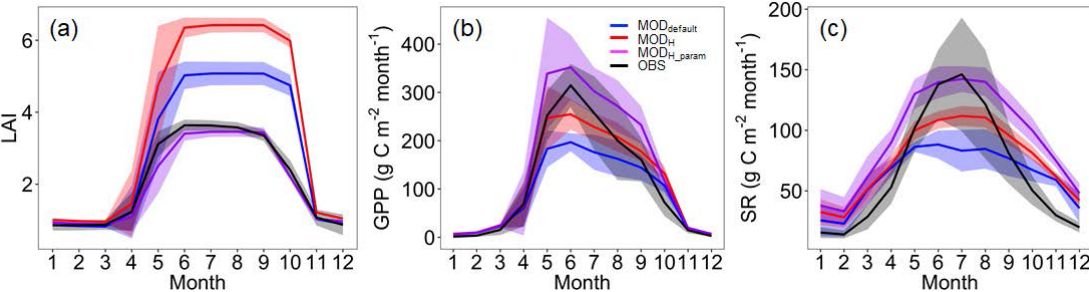
Figure 4. The annual mean cycles of LAI, GPP, and SR. OBS: observation; MOD default : model output before soil water potential improve- ment; MOD H : model output after soil water potential improvement by the Hanson model; MOD H_param : model output after soil water potential improvement by the Hanson model and parameter